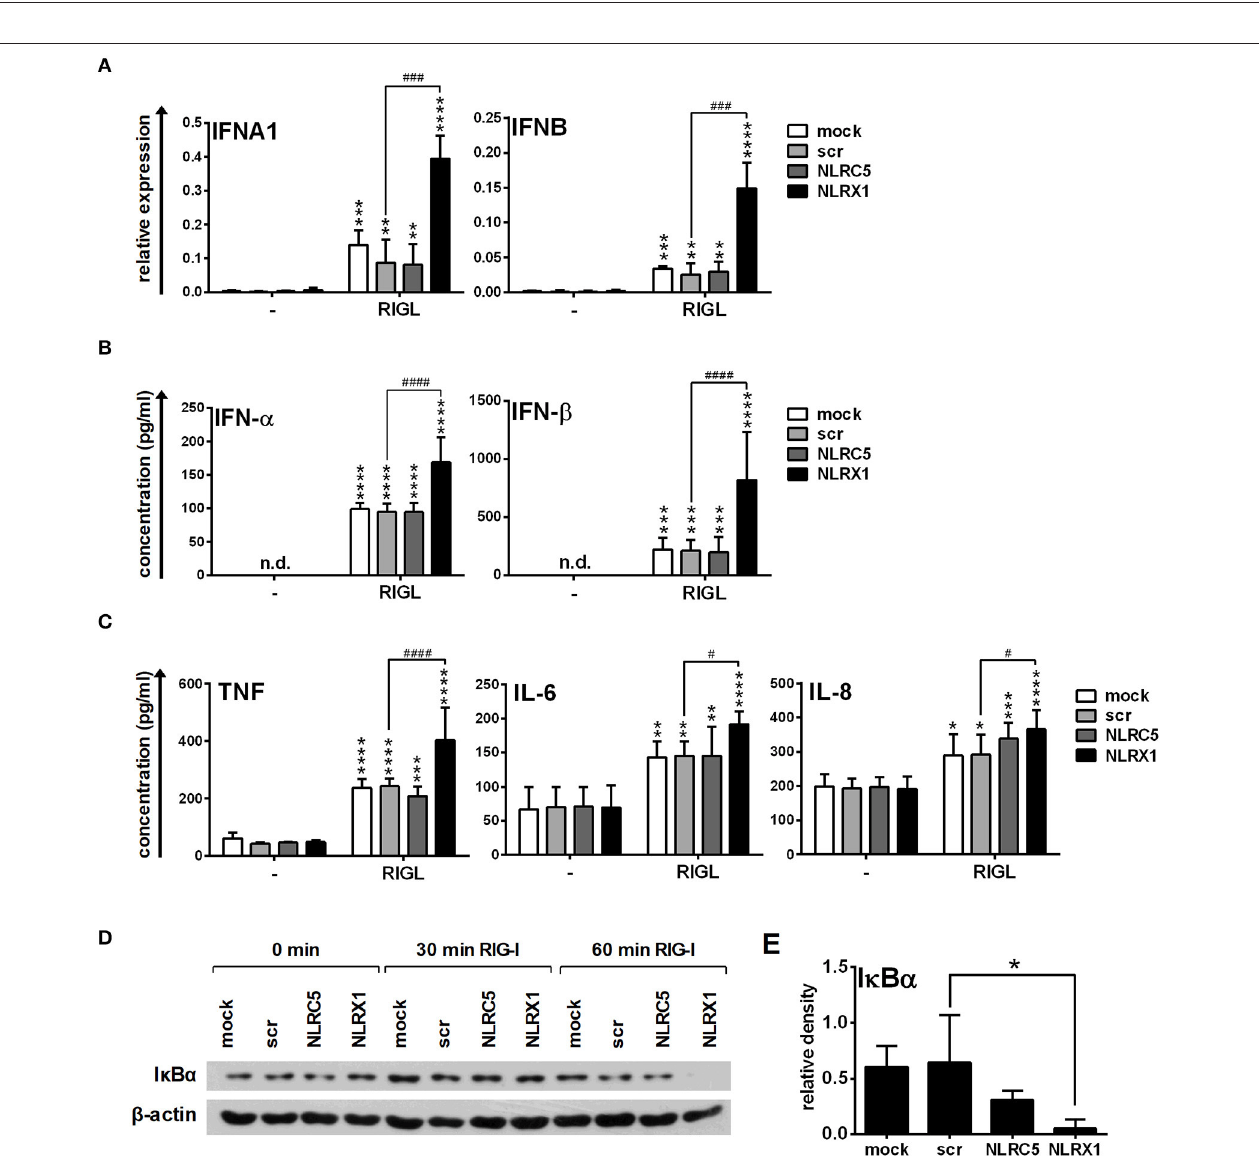
FIGURE 6 | phenotypic analysis of the cells were perfomed by flow cytometry. Cells were gated on forward vs. side scatter to exclude debris (A) and the expression levels of CD14 and CD209 (B) as well as CD1a, CD1c, and CD11c cell surface proteins and cell viability (C) were analyzed. (A–C) Representative dot blots are shown from 3 individual experiments. (B, C) Isotype controls antibodies were used to set gates for positive events and numbers indicate the percentage of positive cells. In case of 7AAD staining the numbers show the ratio of 7-AAD negative live cells.